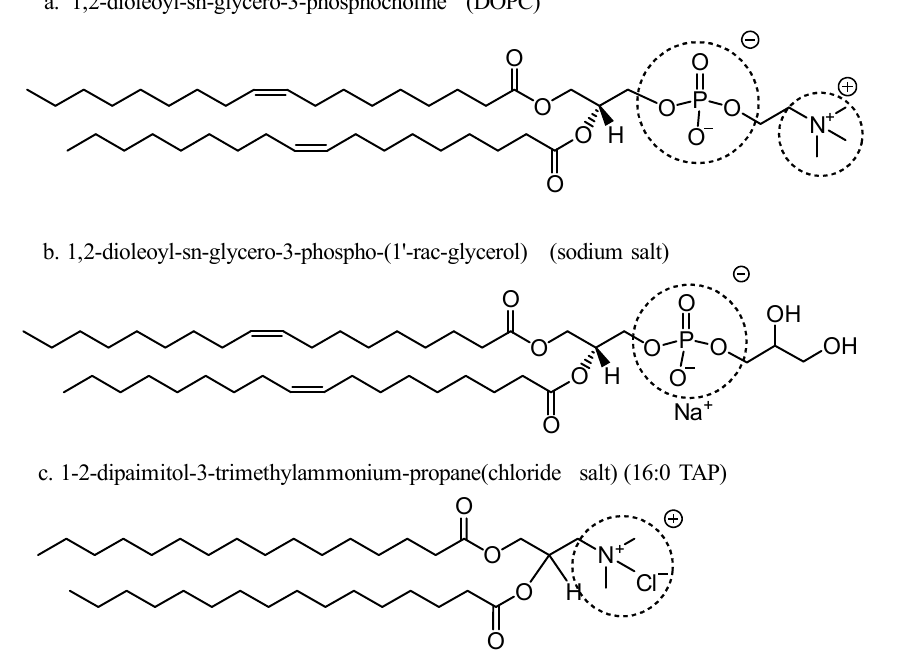
Figure 1. Schemes of the chemical structures of phospholipids with ( a ) zero charge, ( b ) negative charge, and ( c ) a diol-based transfection reagent, positive charge.